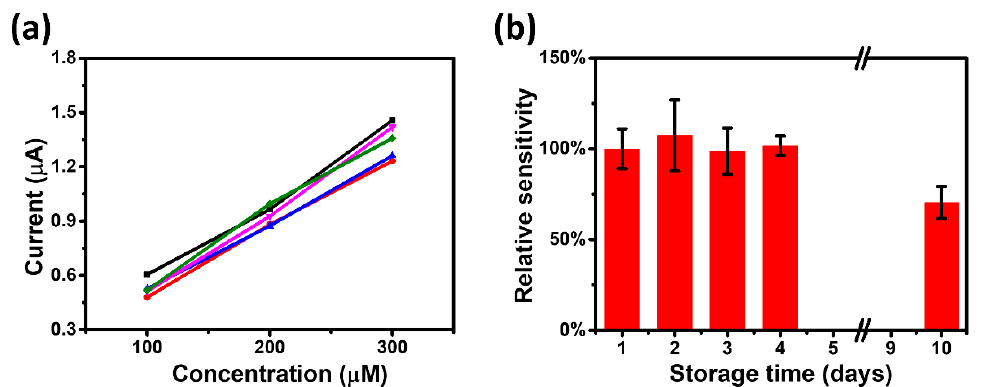
Figure 5. ( a ) The reproducibility of the UAS (five samples). ( b ) The time-stability of the UAS (the error bars were derived from the standard deviation of the measured data for five samples).